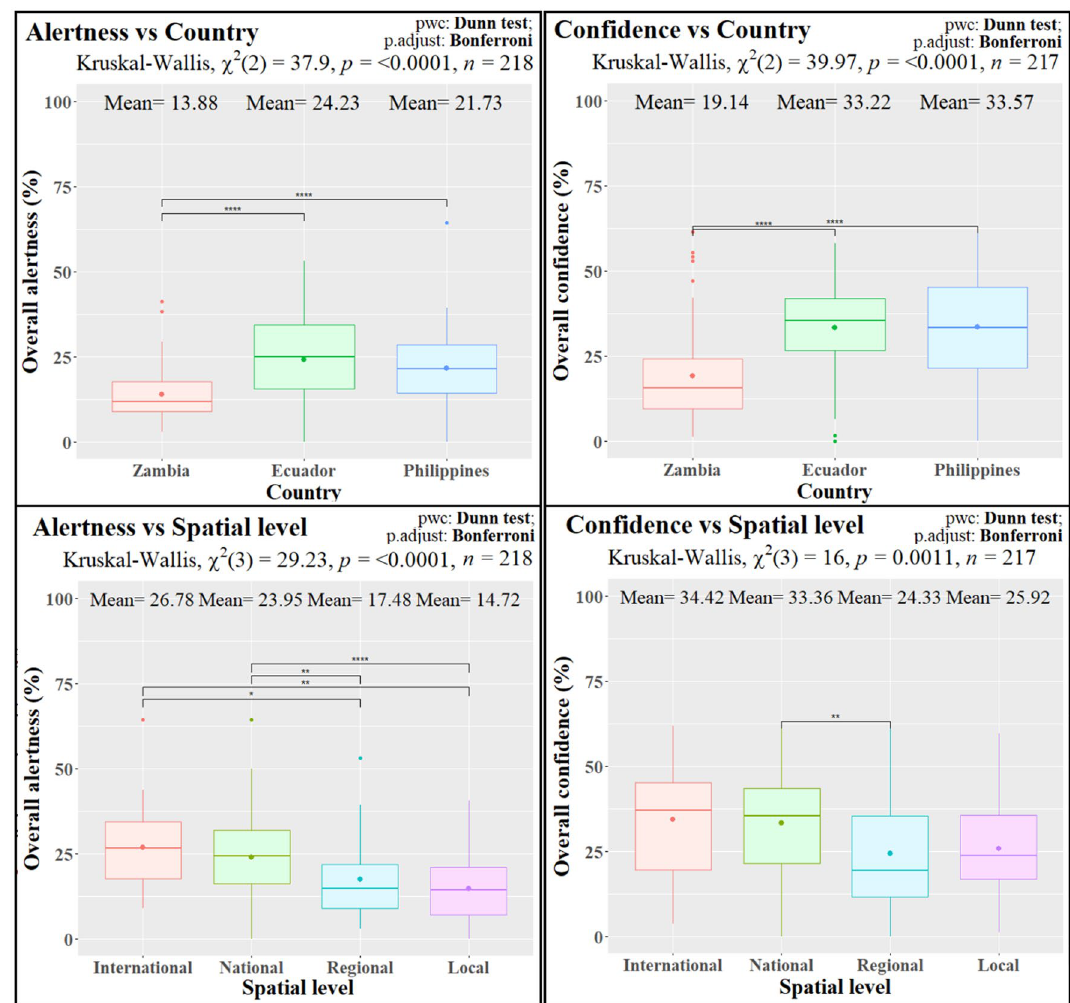
Figure 1. Results of the Kruskal–Wallis and Dunn tests across countries and spatial levels for Alertness (overall alertness about deforestation drivers) and Confidence (overall confidence in policy instruments). Boxplots including mean values (Mean), chi square statistic ( χ 2 ), p-values (p) and number of observations (n) of the Kruskal–Wallis tests and p-adjustment (p. adjust) and p-scores (sign, ****: < 0.0001, ***: < 0.001, **: < 0.01, *: < 0.05, ns not significant [> 0.05]) for the Dunn pairwise comparisons